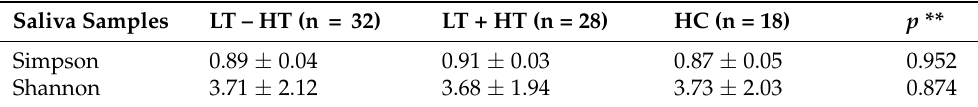
Table 2. Alpha-diversity analysis of bacterial communities between groups (Mean + SD*). Saliva Samples